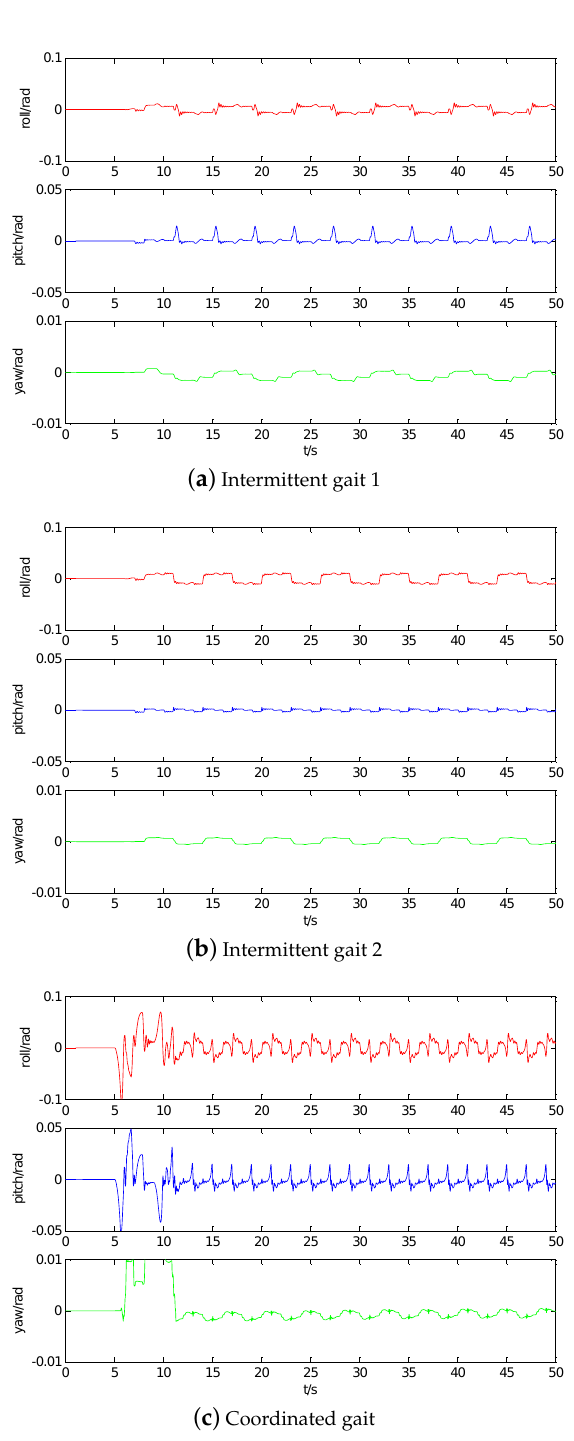
Figure 11. Comparison of attitude of three static